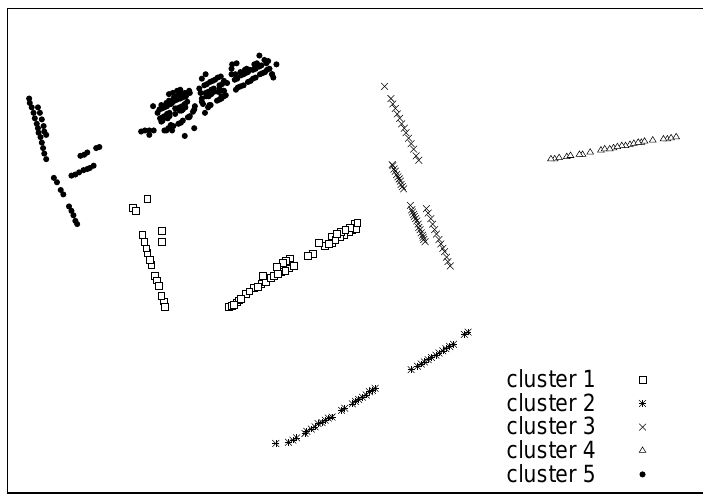
Figure 8. Visual representation of the five clusters considered in Section 6.2. The locations of the nodes correspond to those of the parking sensors in the considered Worldsensing